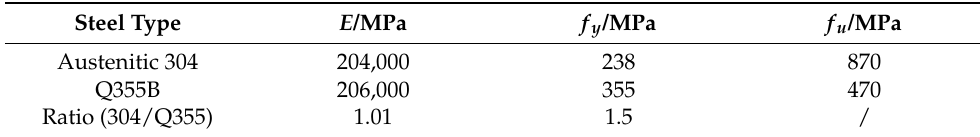
Table 2. Basic mechanical properties of two types of